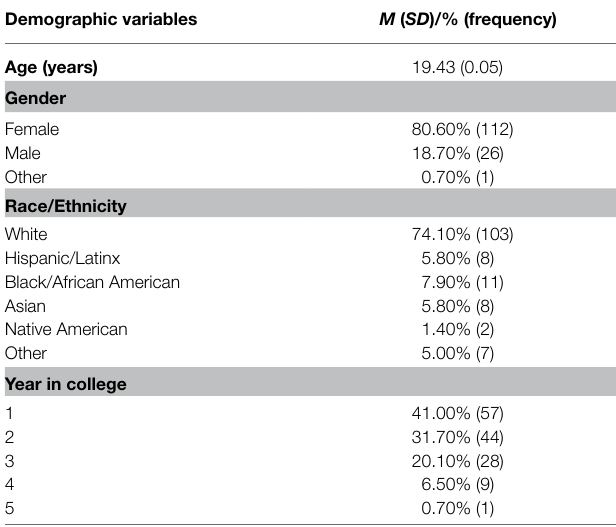
TABLE 1 | Descriptive statistics and frequencies for demographic